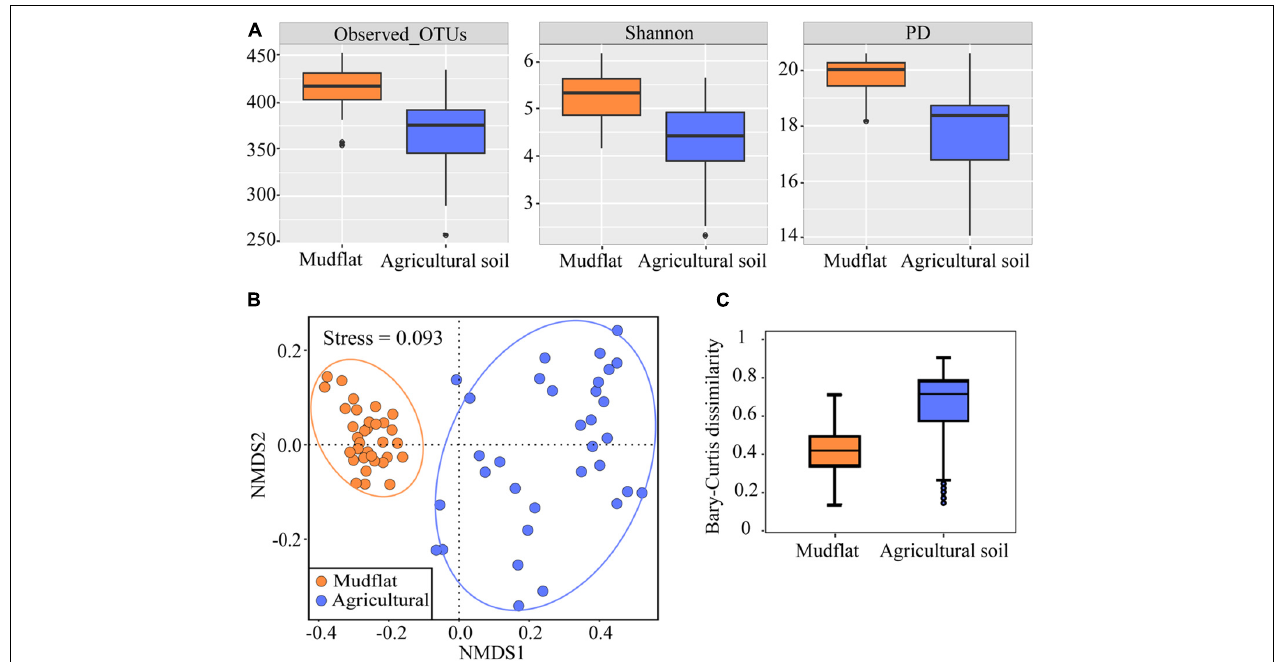
FIGURE 3 | α -diversity and β -diversity of comammox Nitrospira amoA genes in mudflat and agricultural sites. (A) Number of observed OTUs, the Shannon index, and the PD values using OTU similarity thresholds of 95% for the amoA gene. (B) NMDS analysis based on Bray-Curtis dissimilarities of comammox Nitrospira communities. (C) Bray-Curtis dissimilarities between mudflat and agricultural soils, P <